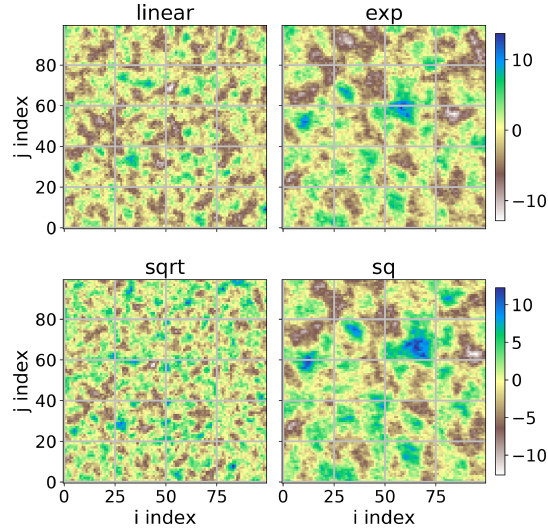
Figure 10. Four random fields generated using the same seed for randomization, which results in exactly the same field for same in- put. The only differing input parameter is the automatic distance- weighting function that was used for fitting the theoretical vari- ogram model. All four fields share the same value range. As the underlying models were made up, neither the values nor the axis coordinates have any meaning. The two coordinate axis names cor- respond to the index of the random field in matrix form i , j